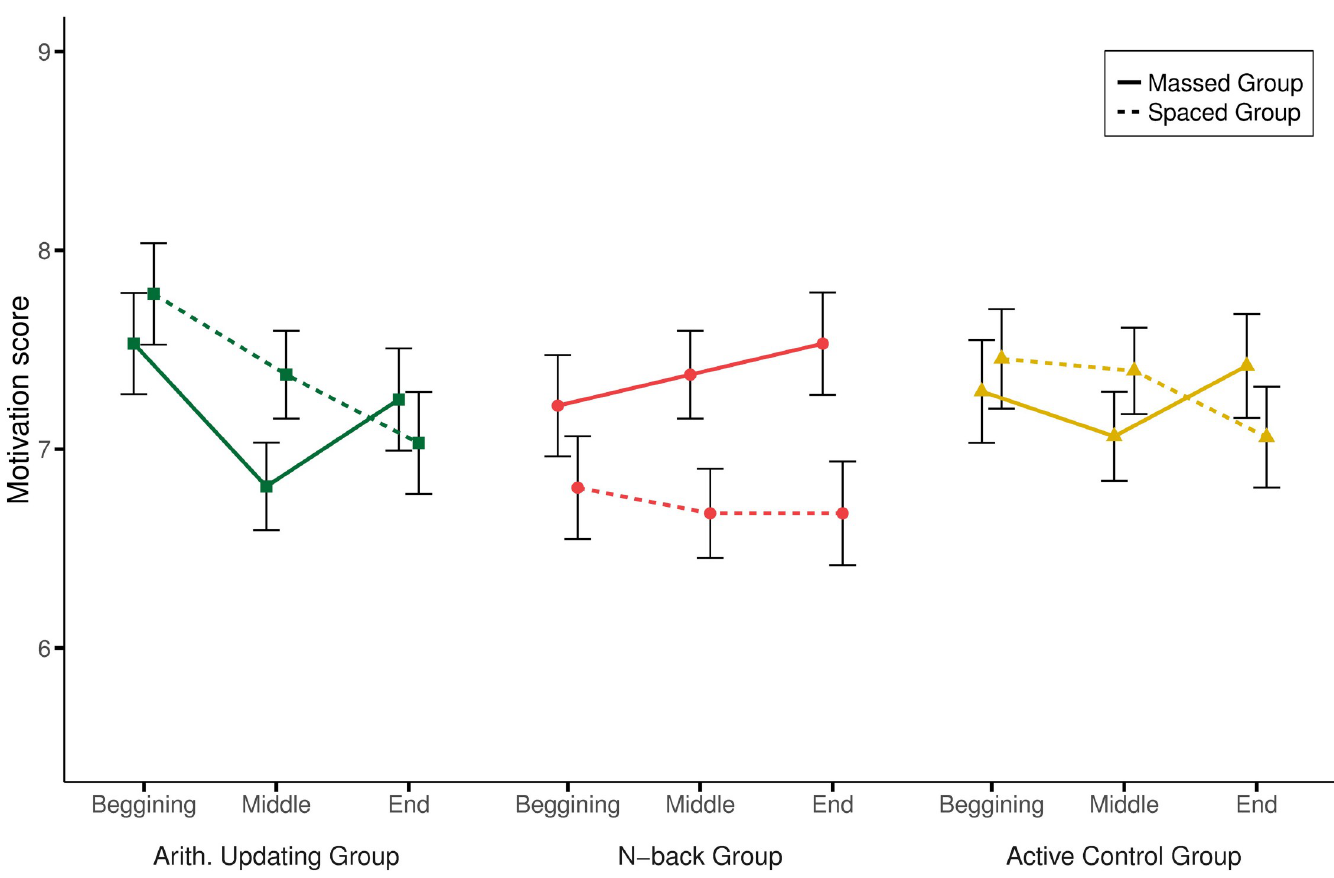
Fig 5. Level of motivation across the training (beginning, middle and end) by group and practice